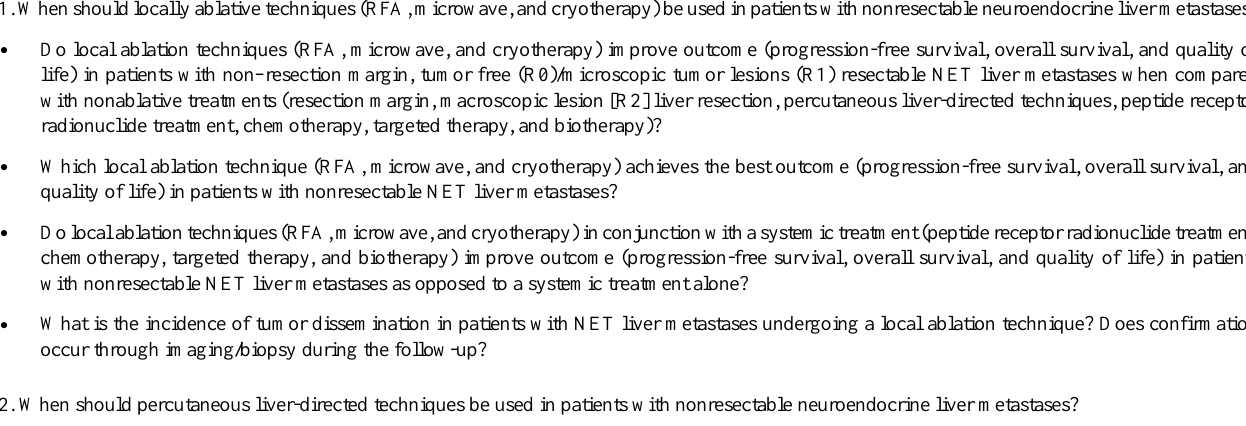
Textbox 1. Questions regarding nonsurgical treatment options for neuroendocrine liver